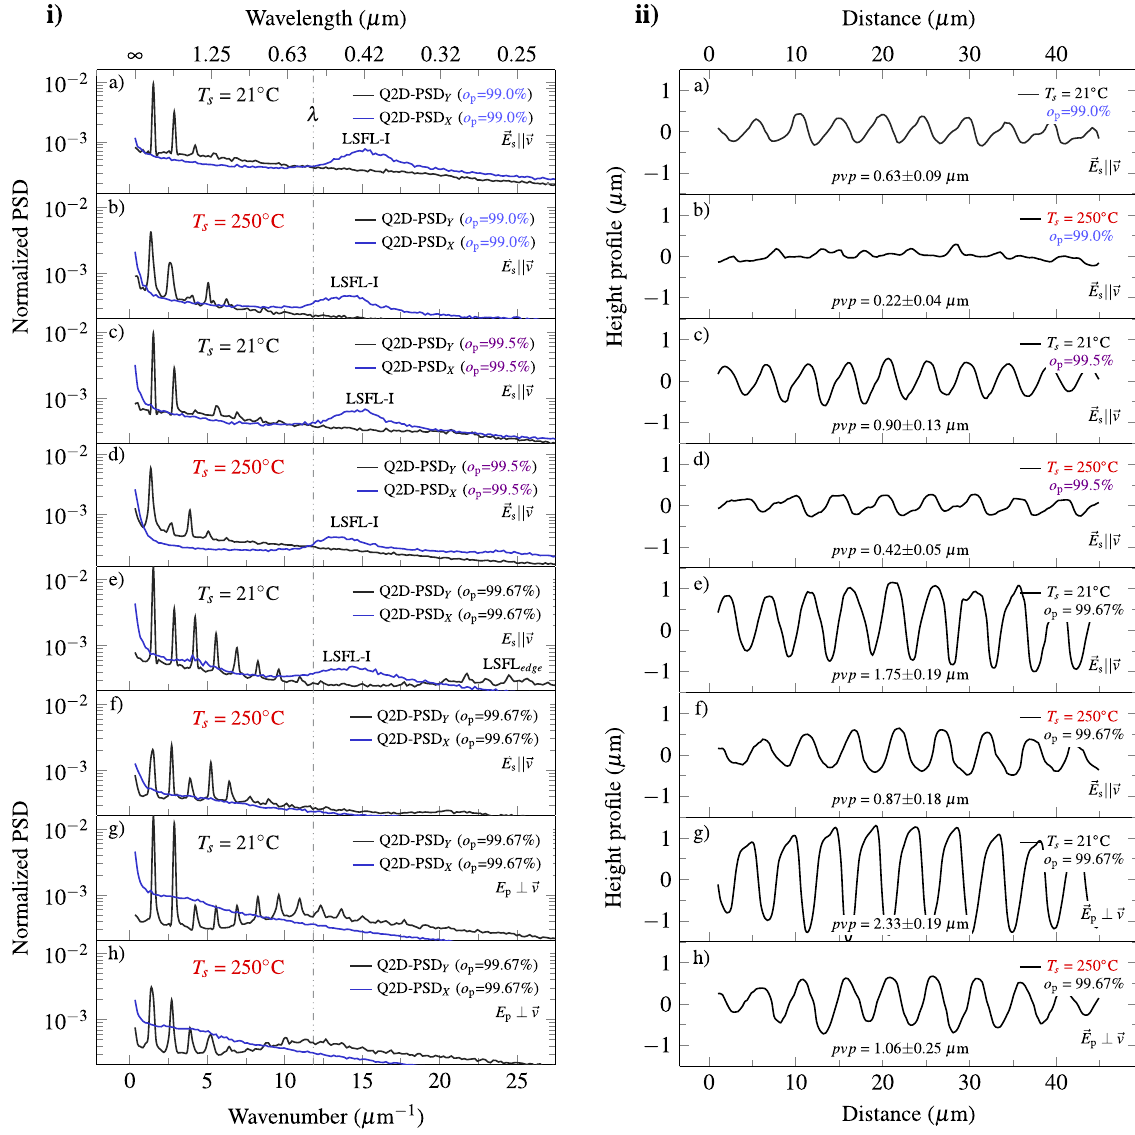
Figure 3. ( i ) Quasi-two-dimensional normalized power spectral density (Q2D-PSD) of surfaces shown as SEM images in Figs. 1 and 2. Since the PSDs are normalized, a decrease in the total signal is to be understood as an increase in the constant part ( k 0.7 µm − 1 , not shown), i.e., smoothness. ( ii ) Corresponding mean height ≤ profiles of the surfaces. The sample temperature T s , the overlap o p and the orientation of the laser polarization E v are depicted in all to the movement of the positioning stage (cid:31)